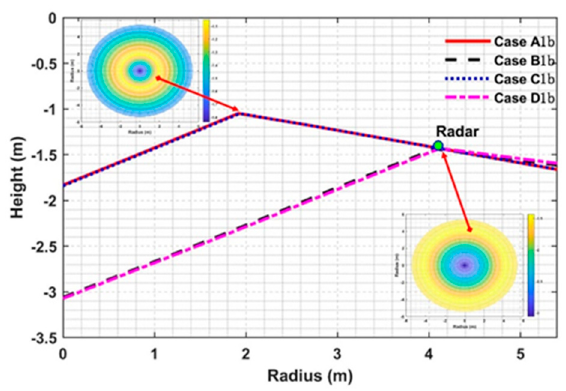
Figure 9. Burden surface profiles after the ore dump for Cases A1b–D1b.